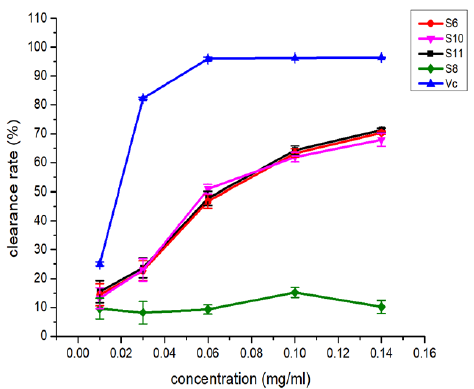
Figure 7. The DPPH ‐ scavenging activity of compounds S6 , S8 and S10 – S11 . Figure 7. The DPPH-scavenging activity of compounds S6 , S8 and S10 – S11